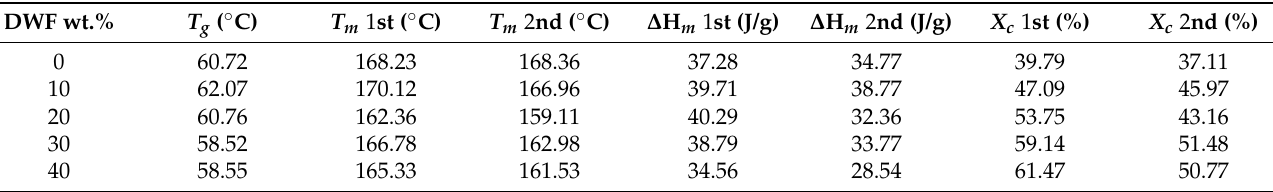
Table 1. Results of DSC analysis for the PLA-KOH composite.